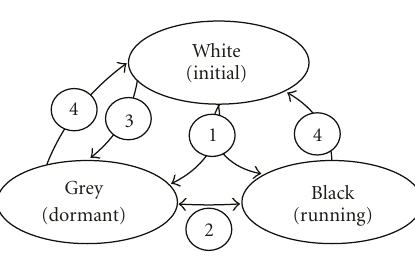
Figure 3: States of sensor